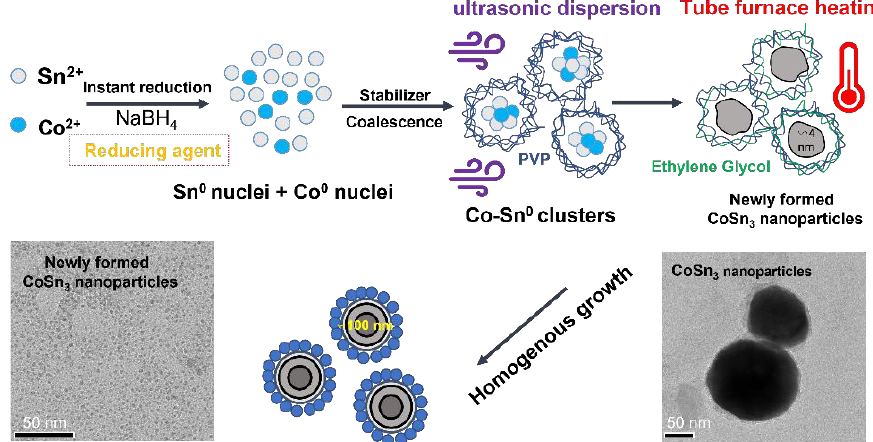
Figure 7. Schematic diagram of the formation of CoSn 3 nanoparticles.